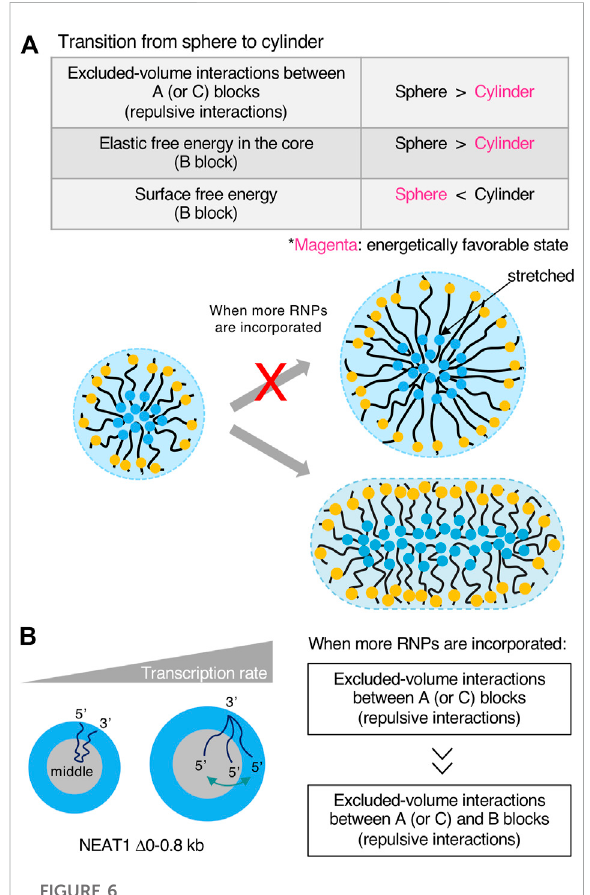
FIGURE 6 Transcription rates in fl uence the shape and internal morphology of the condensates. (A) Free energetic contributions in the sphere-cylinder transition are shown in a table. Free energetically favored states (shape) are shown in magenta when more RNA-protein complexes (RNPs) are incorporated into condensates.Schematicsofthetransitionarealsoshown.Ifalarge micelle forms, the shape is energetically unfavorable from elastic free energy caused by stretches of RNP polymers in the core. (B) The contribution of the transcription rate in the internal morphology of condensates is shown. Excluded-volume interactions betweenA (orC)blocksbecomedominant compared with excluded-volume interactions between A (or C) and B blocks in the core when more RNPs are incorporated into the condensates upon transcriptional